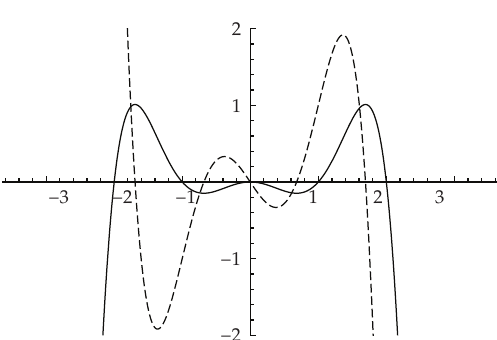
Figure 5: G (cid:3) x (cid:4) (cid:3) solid (cid:4) and G (cid:2) (cid:3) x (cid:4) (cid:5) g (cid:3) x (cid:4) (cid:3) dashed (cid:4) .